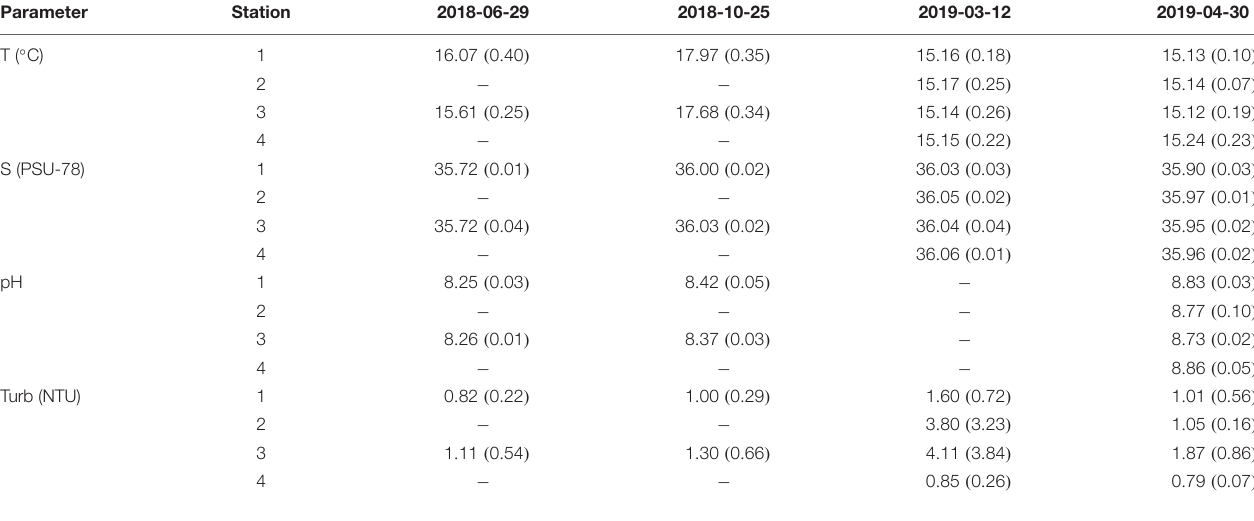
TABLE 2 | Physical–chemical parameters per station average and standard deviation for each campaign: 2018-06-29, 2018-10-25, 2019-03-12, and 2019-04-30. Parameter